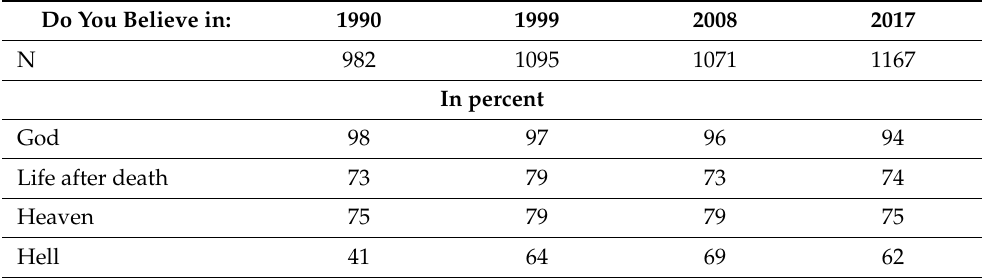
(source: EVS 2015,